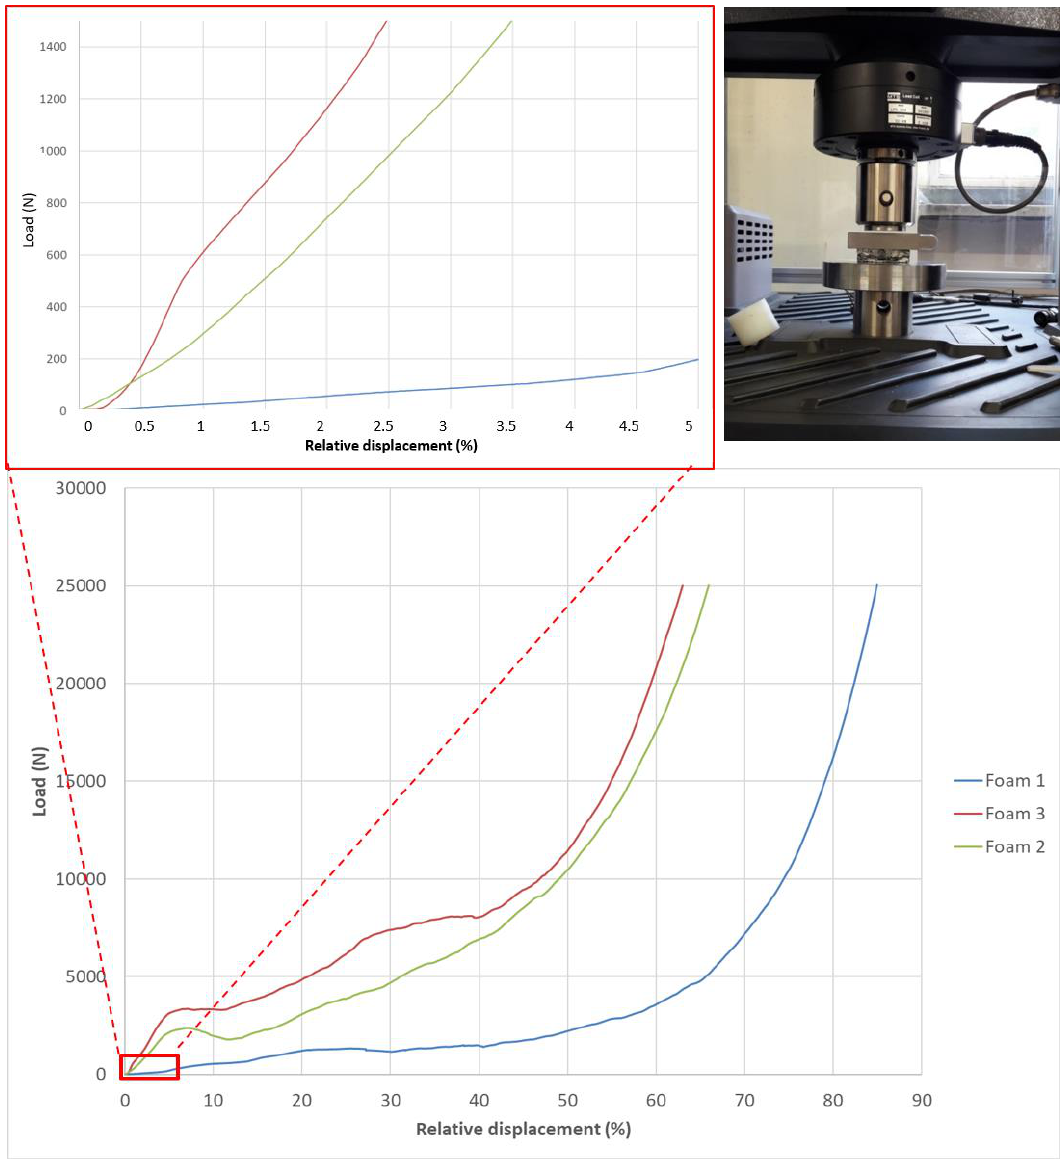
Figure 6. Compression test results of the different